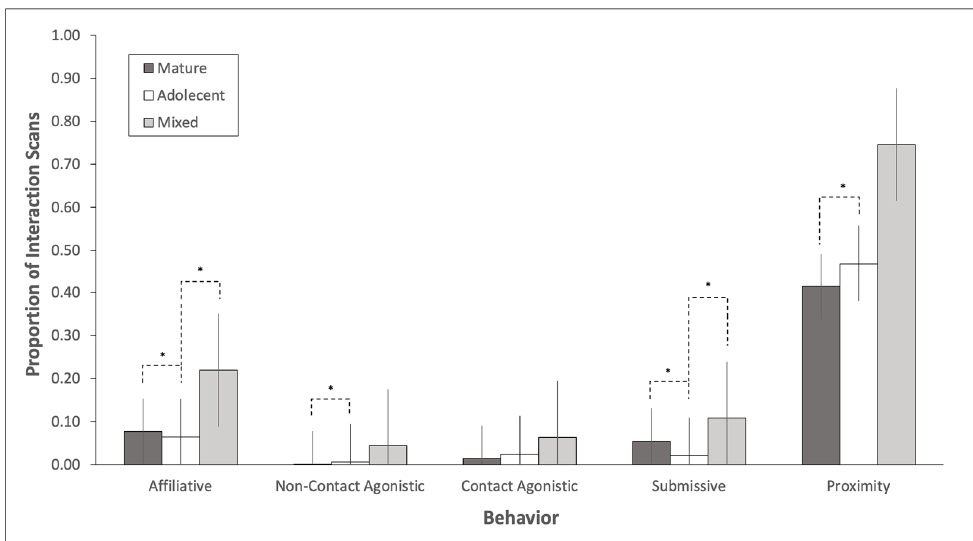
Figure 1. Proportion of scans when an adolescent focal animal engaged in social behaviors in different social groups. Adolescent bulls engaged in significantly more affiliative and submissive behaviors in mixed-age and mature groups compared to with only other adolescents. Adolescent bulls also exhibited significantly less non-contact agonistic behaviors and spent significantly less time in proximity to a conspecific when they were housed with mixed-age groups compared to when they were with only other adolescents. Mature = adolescent focal animal housed with group including only bulls who regularly undergo musth; Adolescent = adolescent focal animal housed with group including only other bulls who do not regularly undergo musth; Mixed = adolescent focal animal housed with group including both bulls who do and do not regularly undergo musth. * indicates p < 0.05.